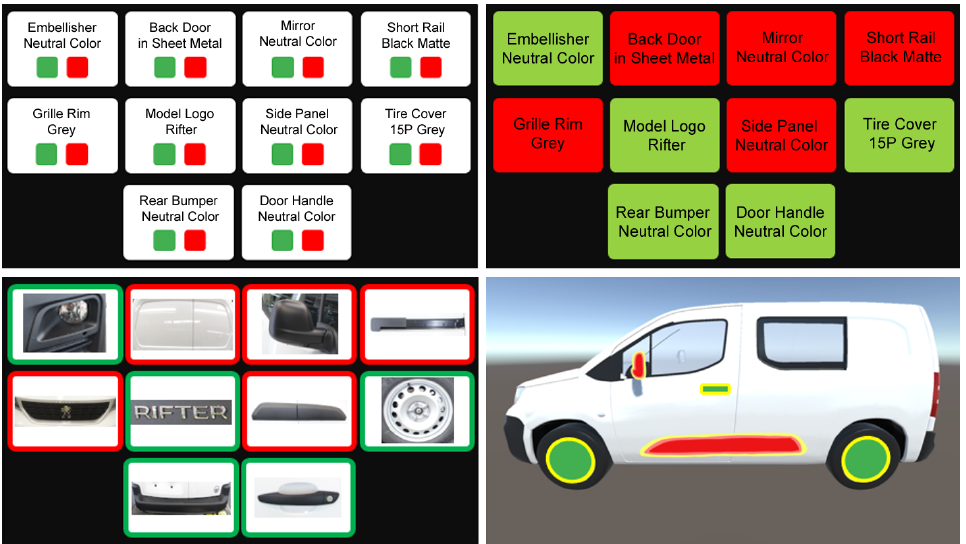
Figure 4. Examples of different studies of the information visualization of the conformity list, with particular focus on the highlighting of the non-conforming